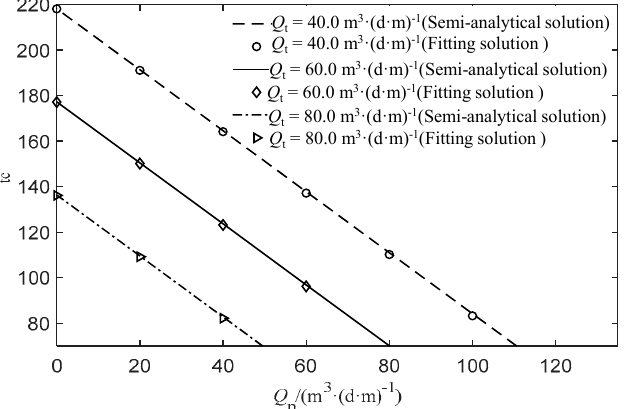
Figure 16. Comparison of fitting results and semi-analytical solution of pressure head on the tunnel crown.